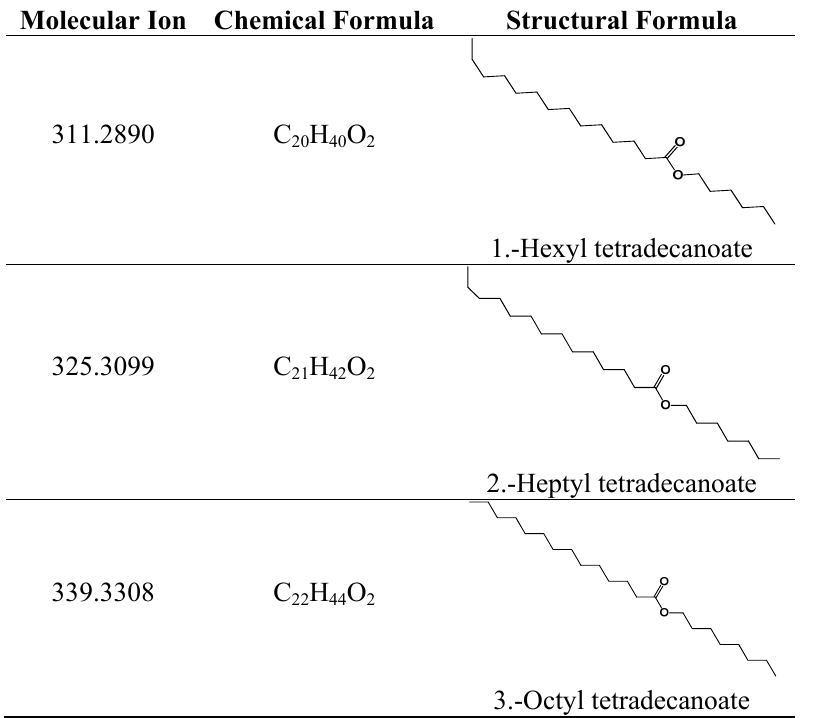
Table 4. Molecular ion, molecular formula and molecular structure of the main components of the white precipitate from fractions 2 and 3 of the chloroform